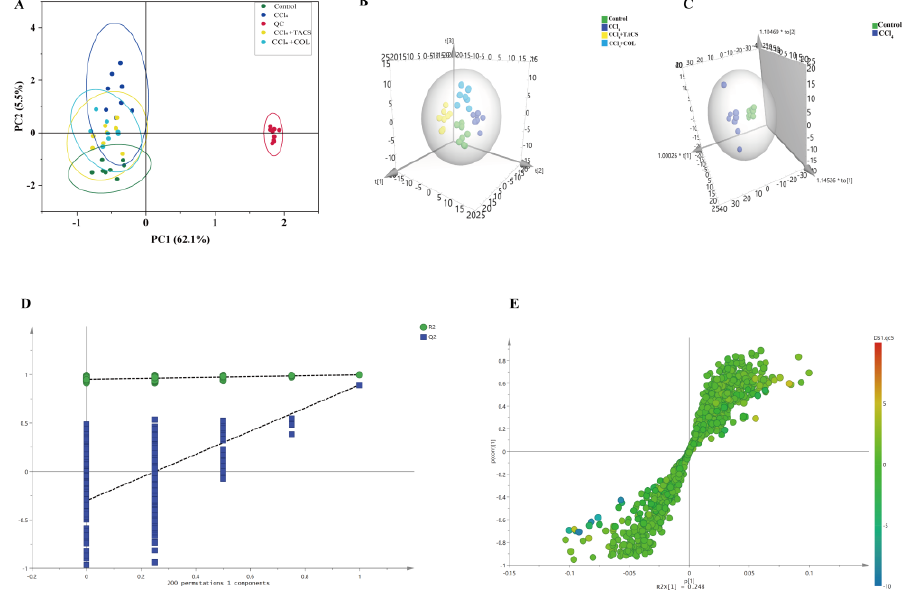
Figure 4. TACS intervention on CCl 4 − induced liver fibrosis rats. ( A ) PCA score plot; ( B ) PLS − DA score plot; ( C ) OPLS − DA analysis of the control and CCl 4 groups; ( D ) Permutation test ( n = 200 times) was used to validate the OPLS − DA model. ( E ) S − plot in control group and CCl 4 − induced liver fibrosis group detected in positive ion mode.